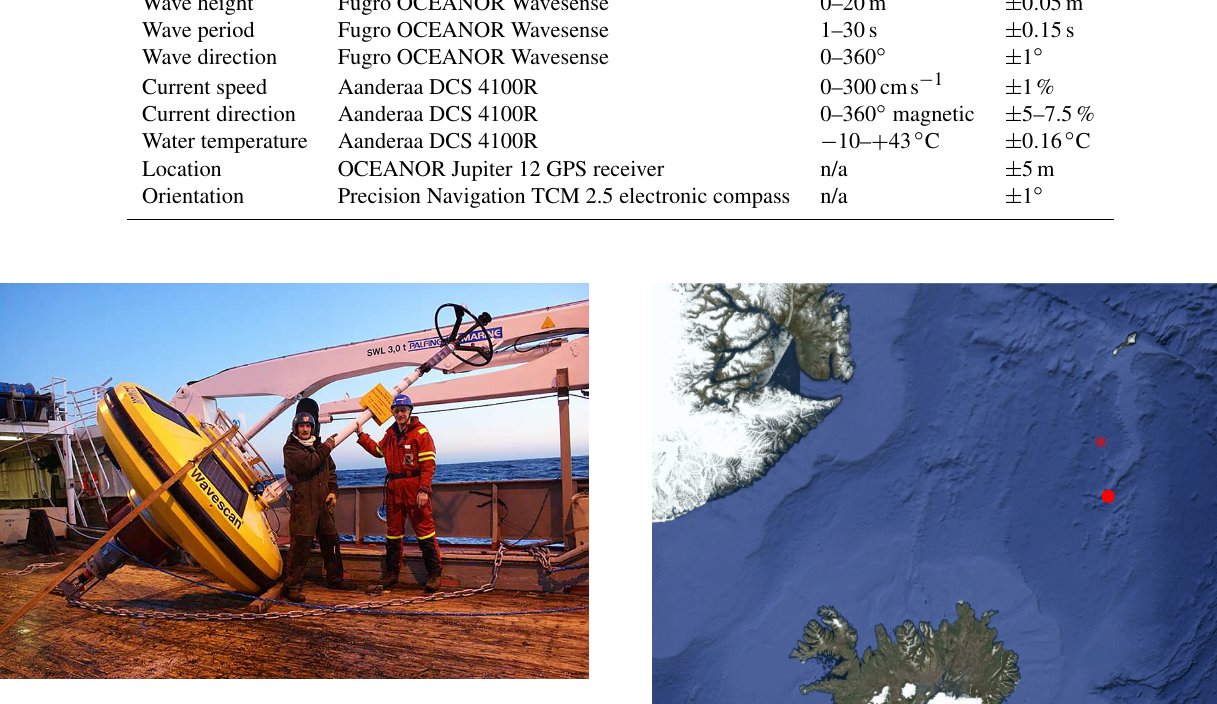
Figure 1. The meteorological buoy on board the Icelandic Marine Research Institute’s vessel Bjarni Sæmundsson on 22 November 2007, the day before deployment. Photo: Sighvatur K. Pálsson.